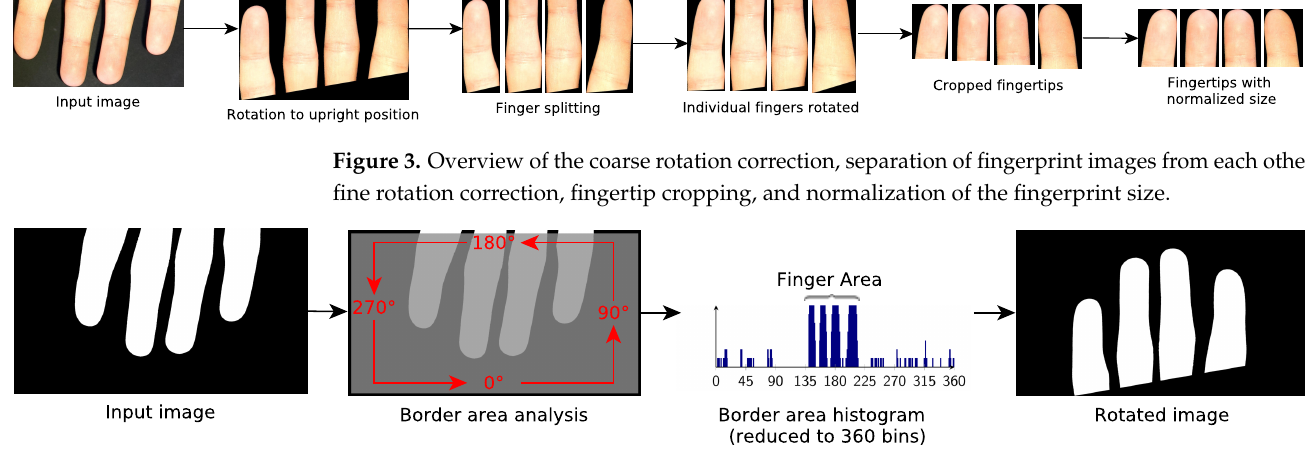
Figure 4. Detailed workflow of the coarse rotation